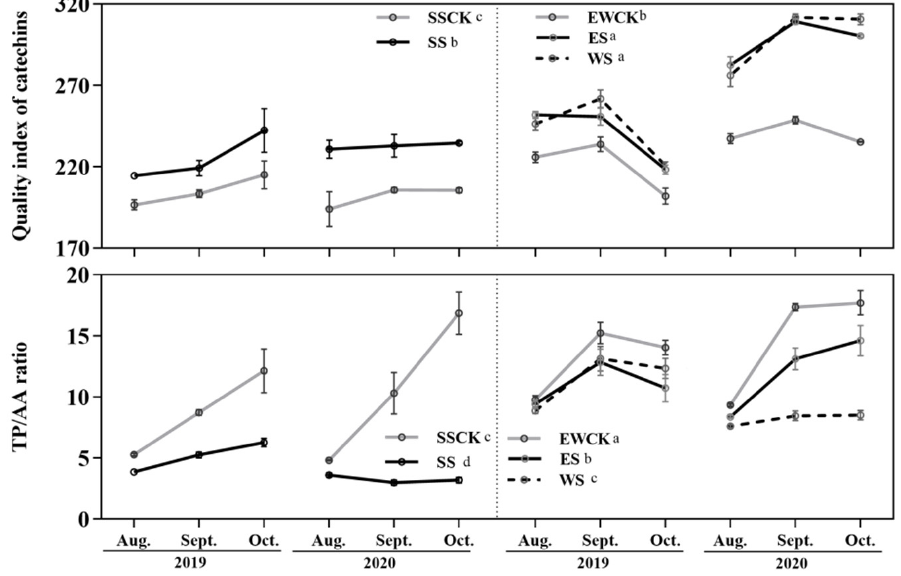
Figure 4. Catechin quality index and phenol/ammonia ratio in the leaves of tea plants under intercropped maize ecological shading in tea plantation.